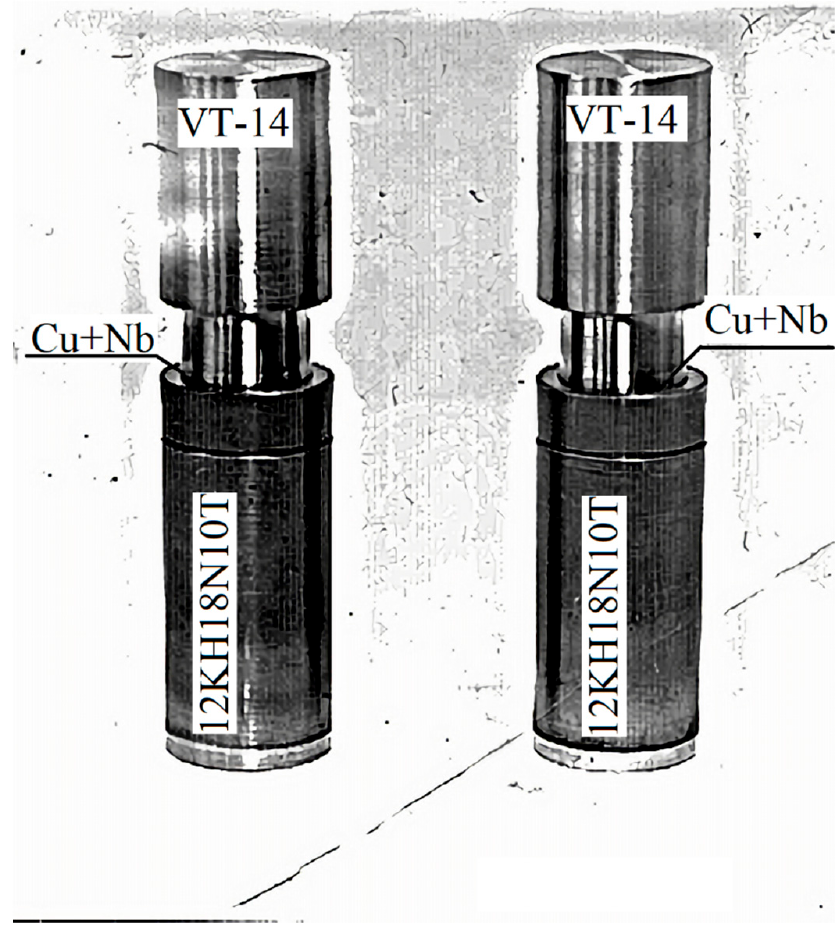
Figure 2. The 12KH18N10T+Cu+Nb+VT-14 sample before welding.